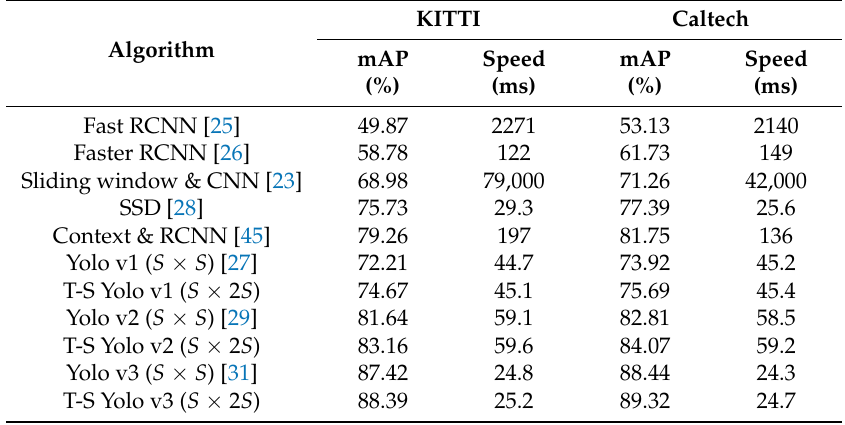
Table 1. Detection accuracy and speed of all lane detection algorithms on KITTI and Caltech datasets.